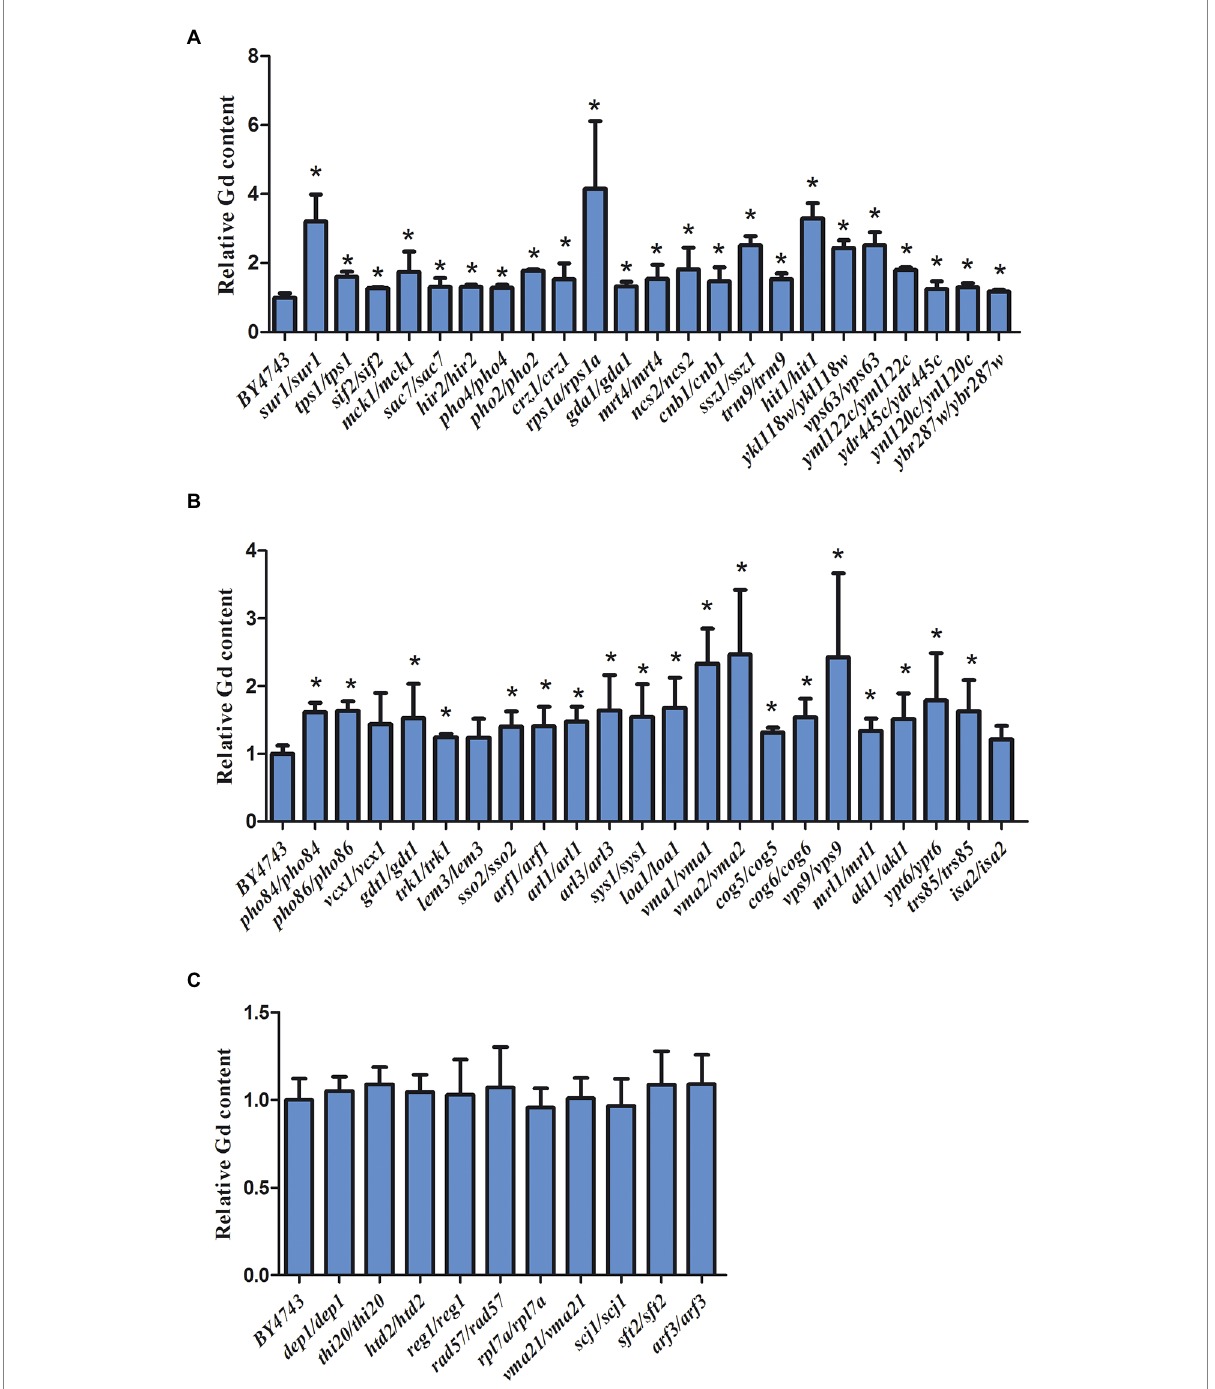
FIGURE 4 Intracellular Gd concentration in 45 Gd-sensitive and 15 Gd-resistant gene deletion mutants under Gd stress. (A) Intracellular Gd concentration in 23 Gd-sensitive gene deletion mutants; (B) Intracellular Gd concentration in 22 Gd-sensitive gene deletion mutants; (C) Intracellular Gd concentration in 15 Gd-resistant gene deletion mutants. Data was expressed as mean ± SEM (n = 6). The difference was analyzed with the single factor variance analysis (LSD’s test) analysis, and the level of significance is set at p < 0.05. Statistically significant differences are denoted by asterisk (*) ( p < 0.05). The experiment was repeated six